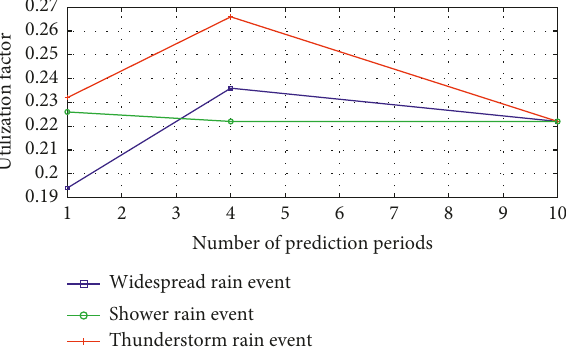
Figure 15: Comparison of utilization